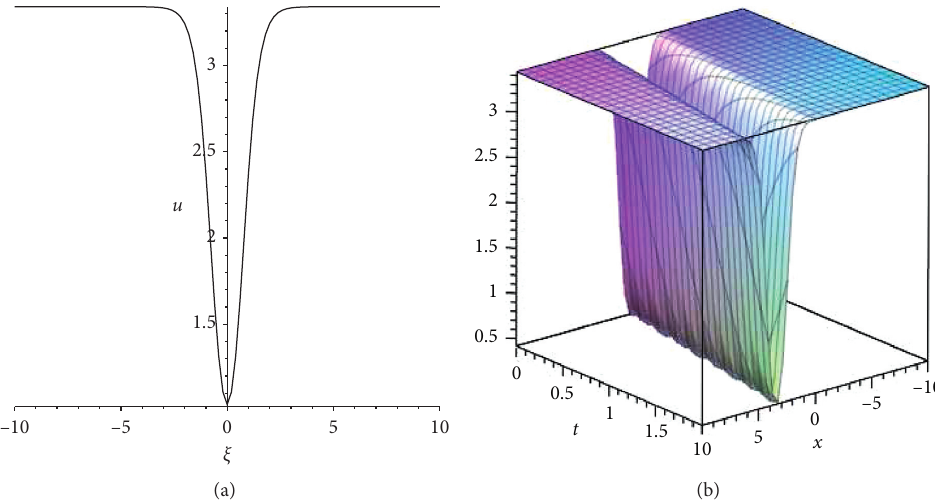
� √ 3 . (a) Solitary wave. (b) Solitary wave